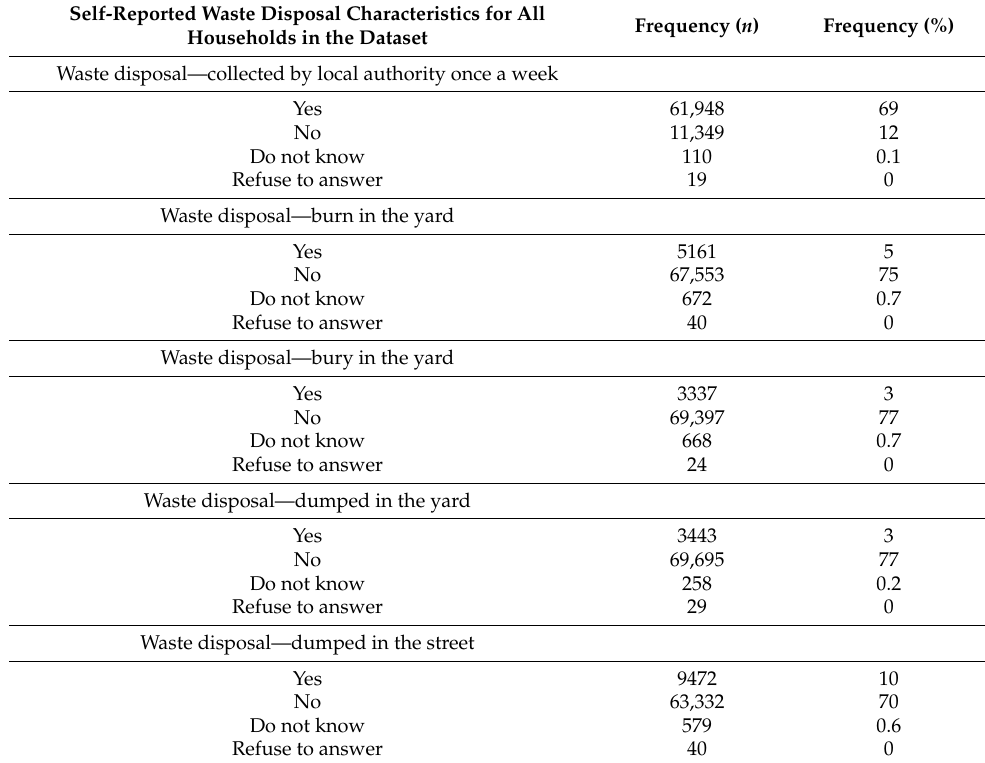
Table 2. Self-reported waste disposal characteristics for all households in the dataset. Percentage frequencies do not sum to 100% due to missing